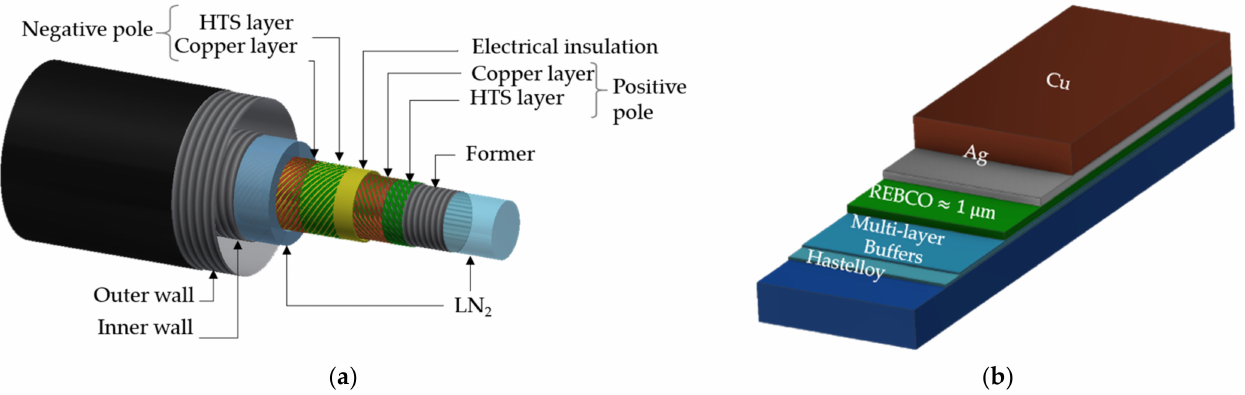
Figure 4. ( a ) Typical diagram of the introduction of a bipolar DC superconducting cable in the railway network; ( b ) view of the different layers of a typical 2G HTS tape.